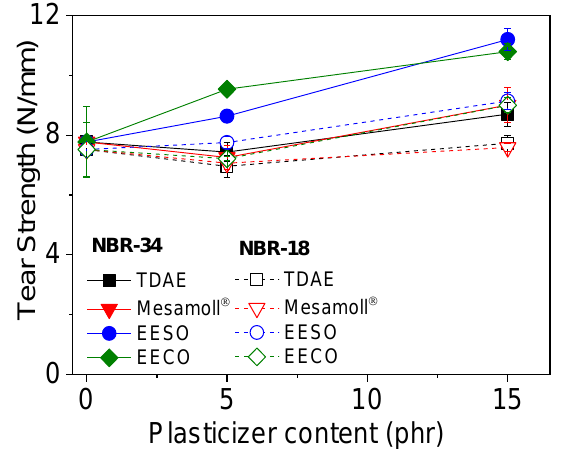
Figure 6. Dependence of tear strength on plasticizer content for NBR vulcanizates.